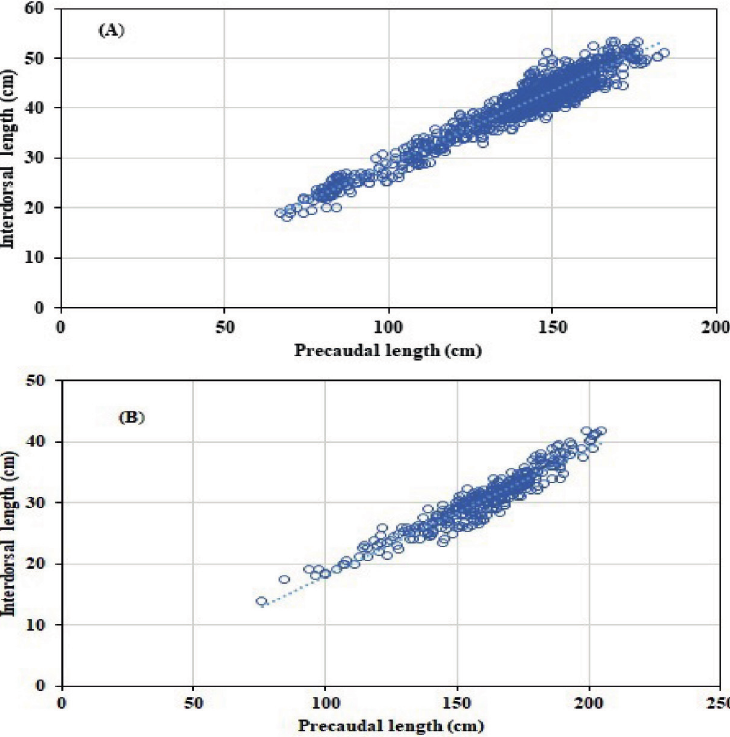
FIGURE 2 | Relationship between interdorsal and length precaudal of the thresher sharks Alopias pelagicus ( A ) and A. superciliosus ( B ). A linear regression, coefficient of determination (R2 = 0.93 A, R2 = 0.91,